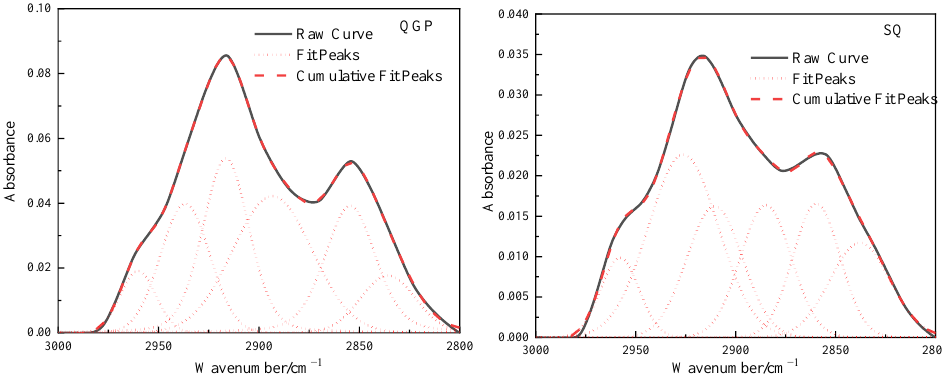
QGP Figure 4. Fitting results and occurrence content of aliphatic hydrocarbons in coal samples. 2.5. Hydroxyl Structure The 3650 – 3000 cm −1 in the FTIR spectrum of the coal sample is the stretching vibration band of the hydroxyl functional group in the coal, as shown in Figure 5, and the total unstacking is 6 – 8 sub-peaks. Hydroxyl is an important functional group that affects the reactivity of coal. It has a strong activation effect when breaking or forming cross-linking bonds and has a great impact on coal naturally [15]. Hydrogen bonds are used to connect the topologically distant and spatially compact parts of the network chain [11]. In this interval, hydroxyl groups form different hydrogen bonds with different hydrogen bond acceptors. The hydrogen bond force is 10 times that of the non-specific intermolecular force and plays an important role in the stability of the coal molecular network [13]. The sharp peak near 3616 cm −1 is the free hydroxyl stretching vibration region, This is because the hydrogen bond between the hydroxyl groups cannot be formed due to steric hin- drance, or the hydrogen bond is very weak. Most scholars believe that this peak is the vibration of free hydroxyl groups in coal, and some scholars attribute it to the crystal wa- ter in clay minerals [16]. The contents of free hydroxyl groups are 2.96%, 5.99%, and 4.46%, respectively. Free hydroxyl groups have higher activity than alcohols and phenols and can react with other functional groups at low temperatures to convert into carbonyl or carboxyl groups. The occurrence content in coal is low. The hydrogen bond formed be- tween the hydroxyl group and the π electron cloud on the aromatic ring is called the OH-